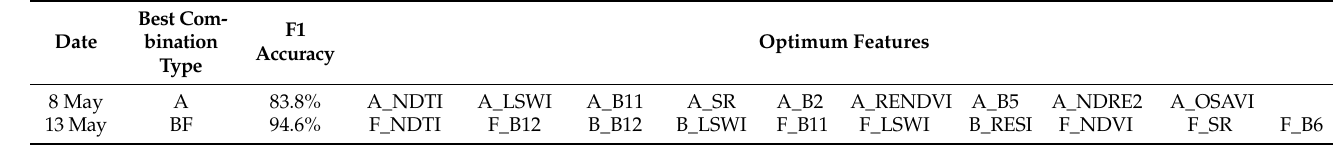
Table 10. The top-10 optimal feature sets of best rice combination types for each period in